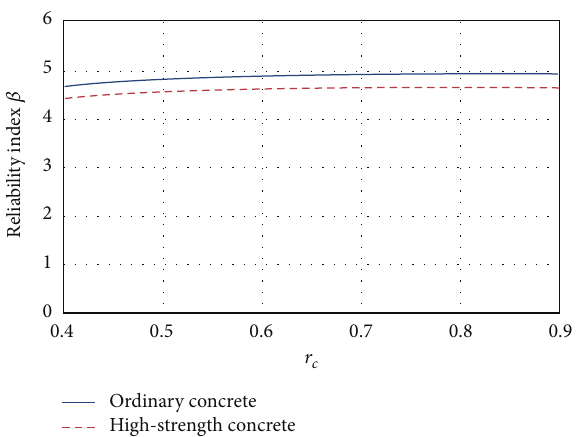
Figure 11: Influence of the slenderness; 𝑒 = 0.01 .